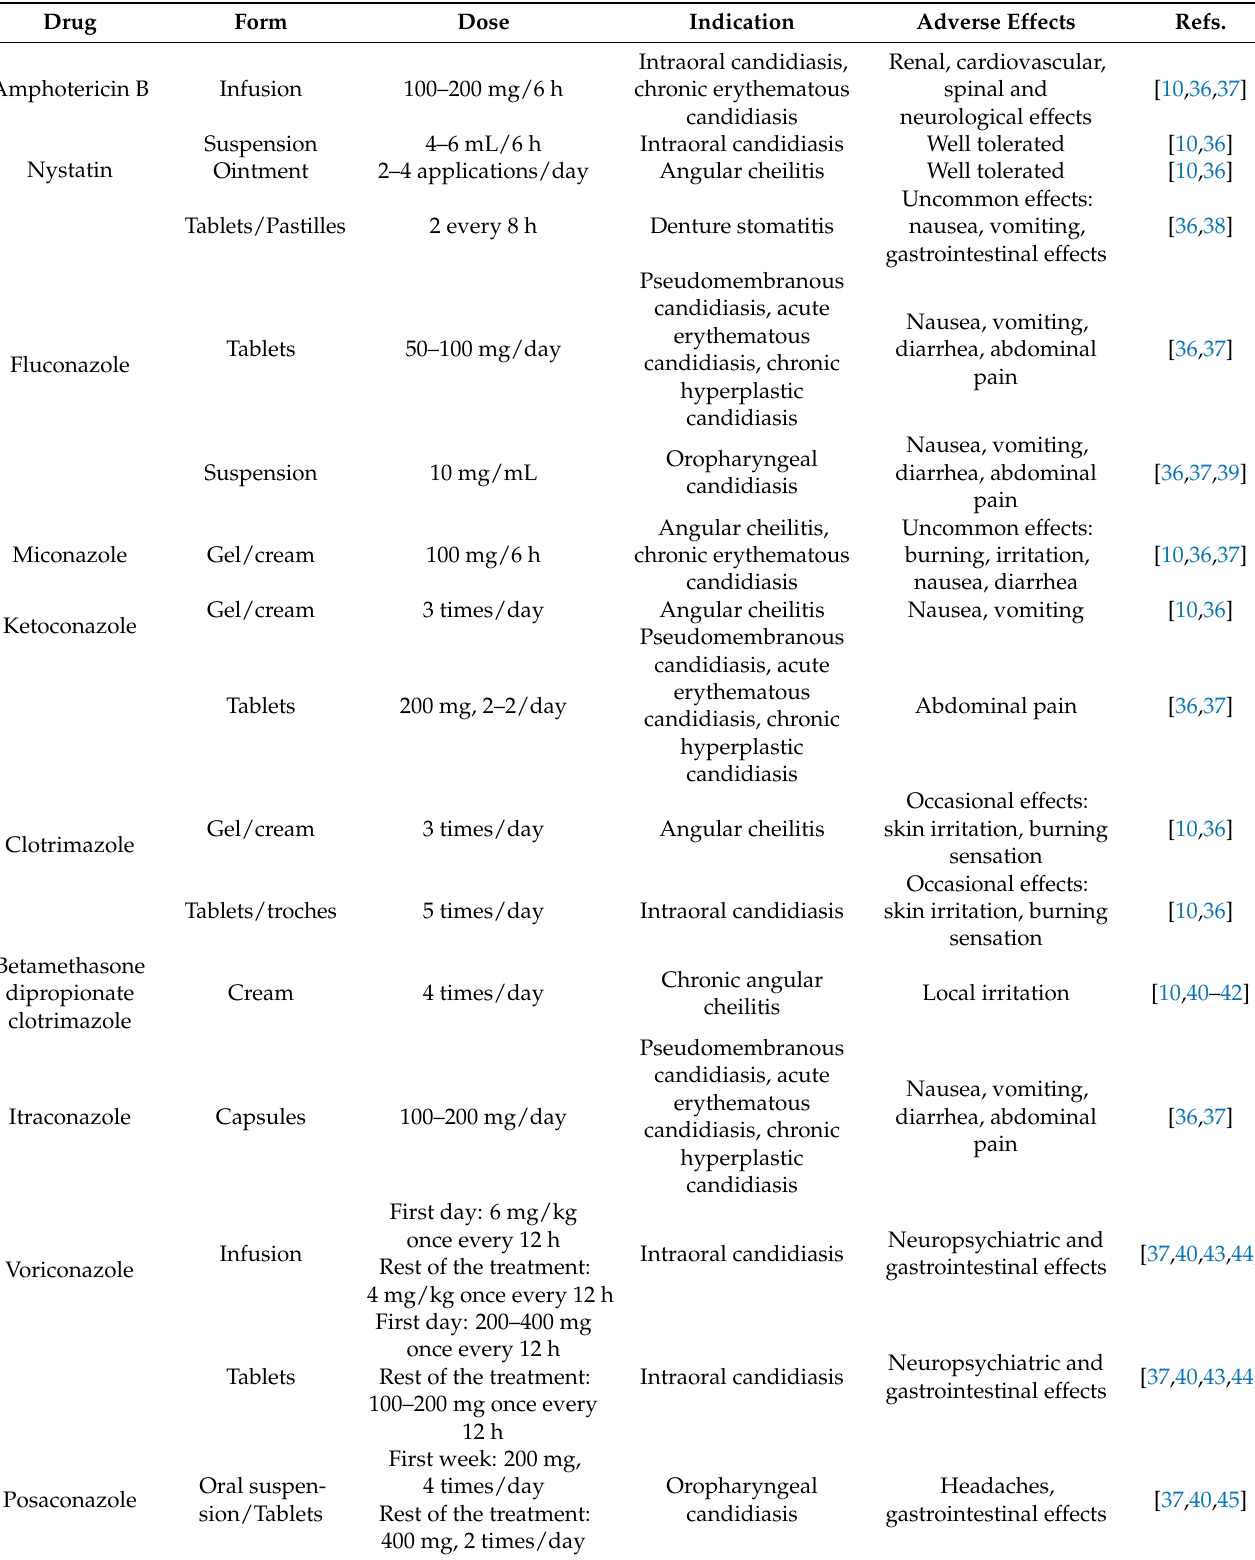
Table 2. Antifungal